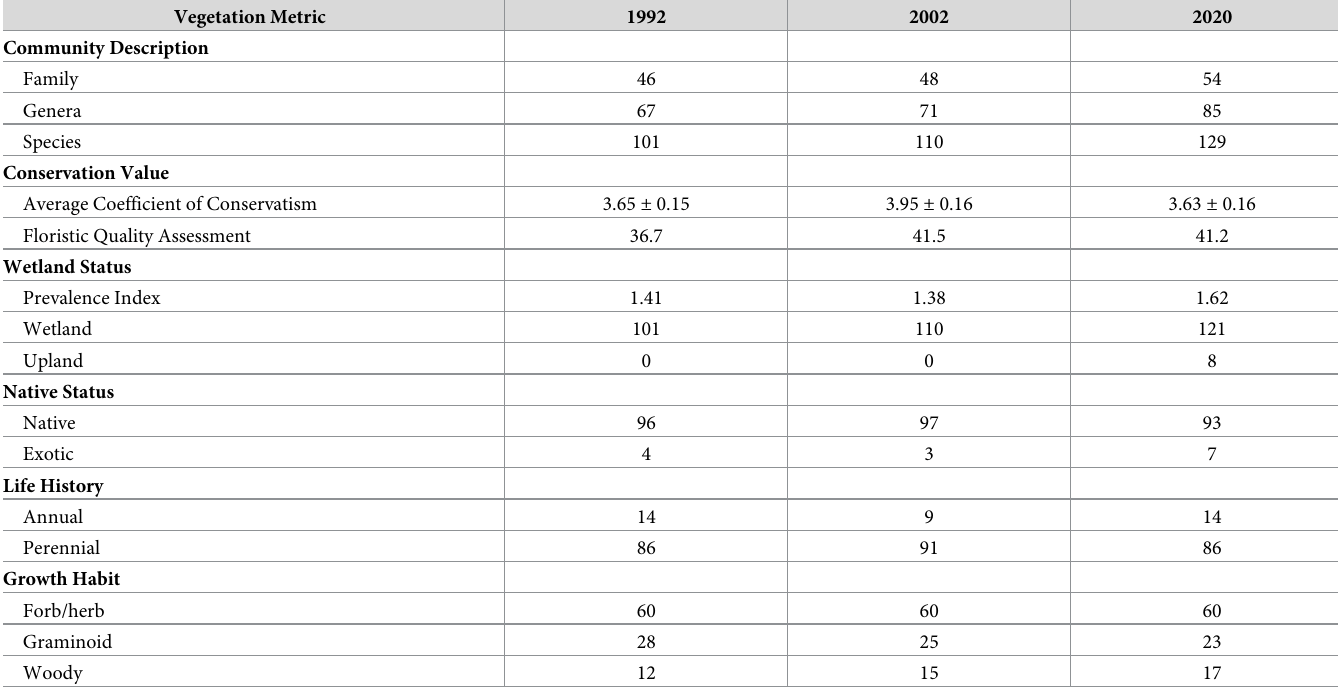
Table 1. Descriptions of the vegetation community from each floristic survey of Quarry Pond. Vegetation Metric